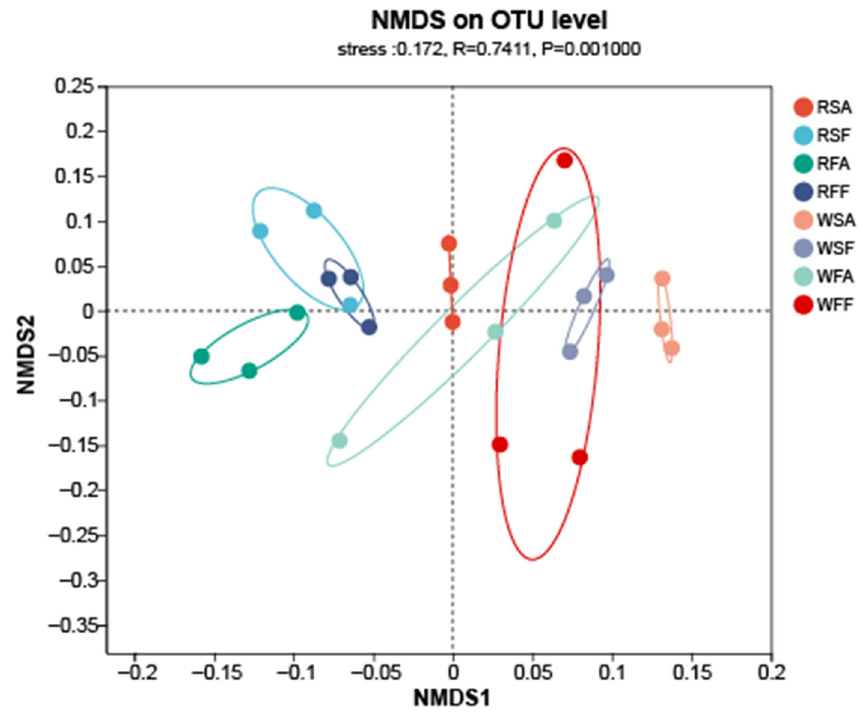
Figure 2. The soil bacterial community structure changes with different irrigation water qualities, methods, and techniques. Non-metric multidimensional scaling (NMDS) based on the Bray–Curtis of OTU clustered by 97% similarity of the bacterial